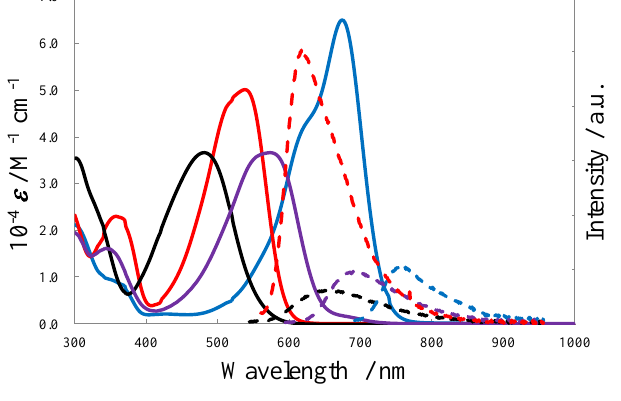
Table 2. Photochemical data for E -5 , P